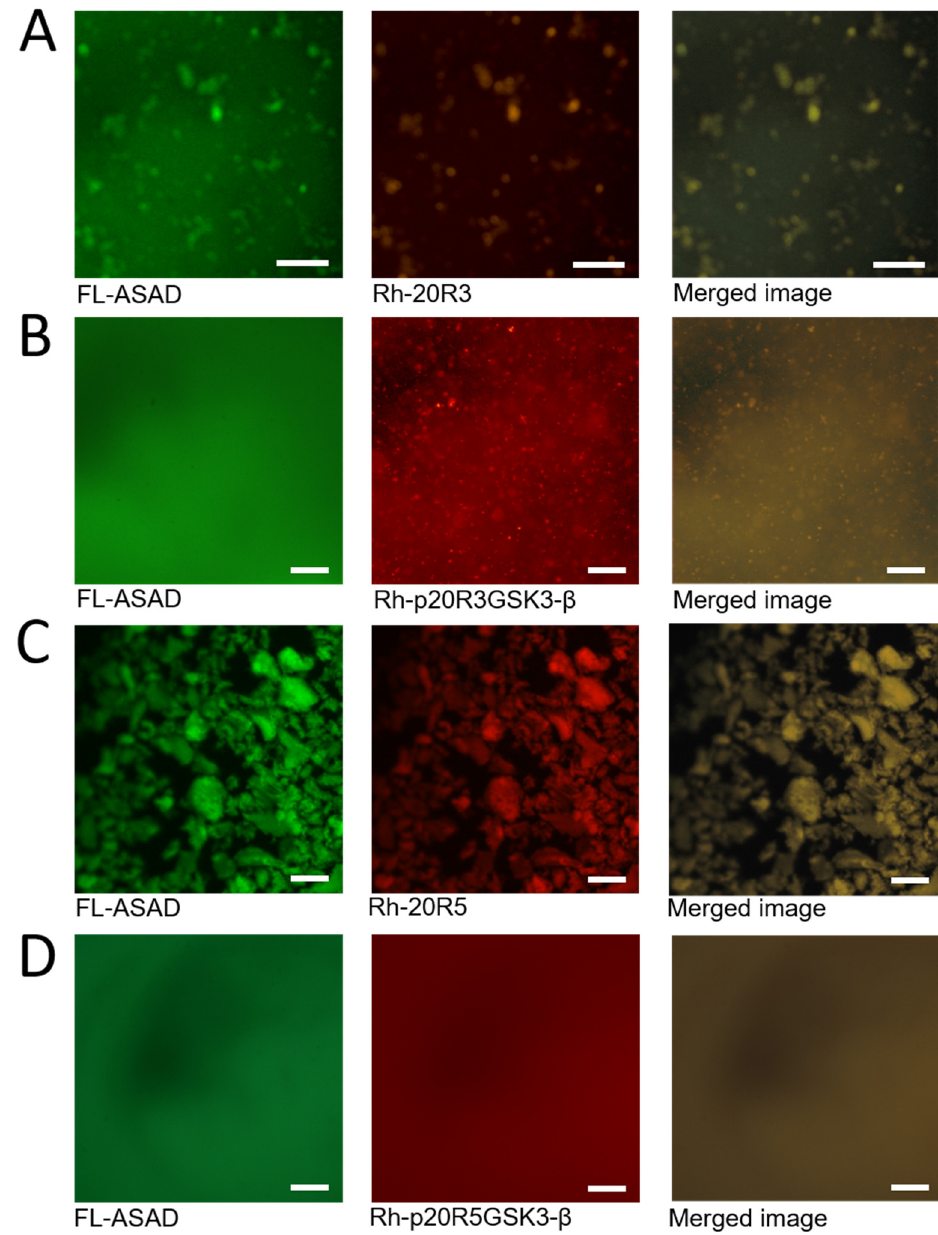
Figure 4. The effect of phosphorylation on droplet formation by APC-derived peptides. ( A ) The ASAD labeled with fluorescein (green) and 20R3 labeled with rhodamine b (red) are located at the same clusters (yellow) ( B ) Phosphorylation of 20R3 prevented co-aggregation with the ASAD. ( C ) ASAD labeled with fl uorescein (green) and 20R5 labeled with rhodamine b (red) located at the same clusters (yellow) ( D ) Phosphorylation of 20R5 prevented co-aggregating with the ASAD. All scale bars = 20 µm.